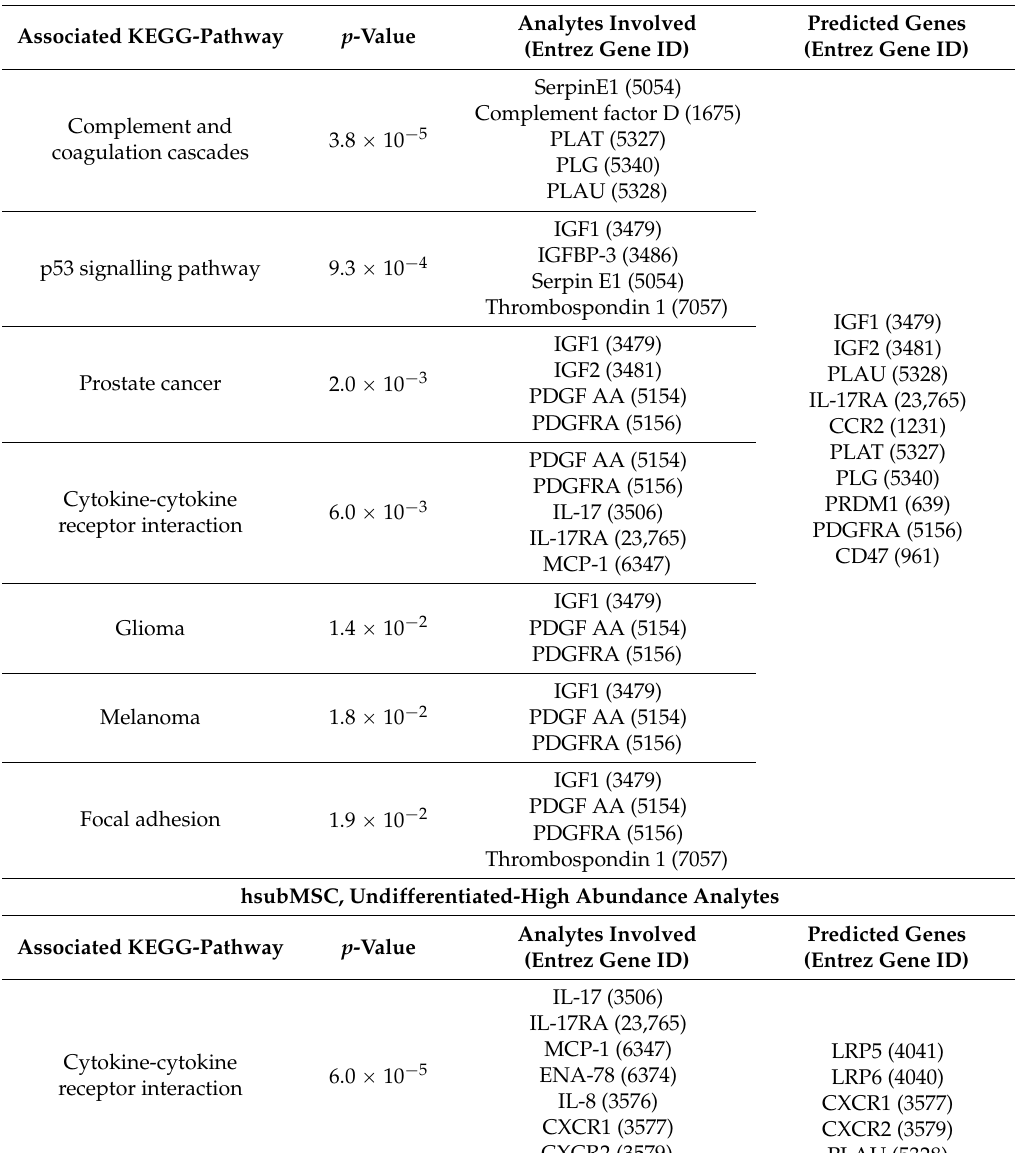
Pathway analysis by the David database of high abundance analytes secreted by undifferentiated hbmMSC and hsubMSC and 10 potential interaction partners as predicted by the STRING database (input of analytes as summarised in Tables S1 and S2). Associated KEGG-pathways with p -values of significance as well as analytes involved are